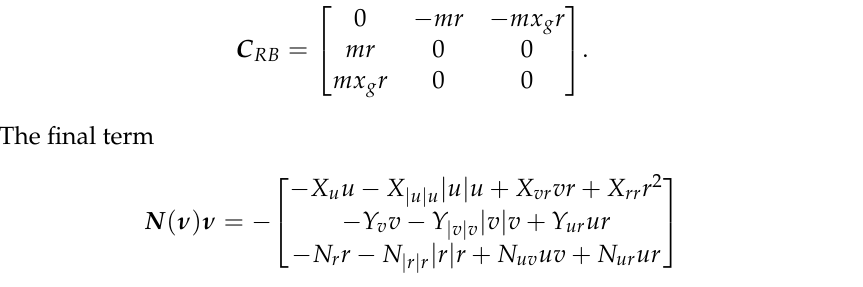
Table 1. Description of all parameters used for USV modeling. Parameter Description Unit m Displacement kg x g x b -coordinate of center of gravity m J comb Moment of inertia w.r.t. the z b axis (incl. hydrodynamic effects) kgm 2 X ˙ u Hydrodynamic mass in x b -direction kg Y ˙ v Hydrodynamic mass in y b -direction kg Y ˙ r Coupling coefficient of hydrodynamic mass kg · m N ˙ v Coupling coefficient of hydrodynamic mass kg · m Linear hydrodynamic damping in x b -direction N Linear hydrodynamic damping in y b -direction N Linear hydrodynamic damping around z b -axis Nm X vr Coupling coefficient of hydrodynamic damping N Coupling coefficient of hydrodynamic damping Coupling coefficient of hydrodynamic